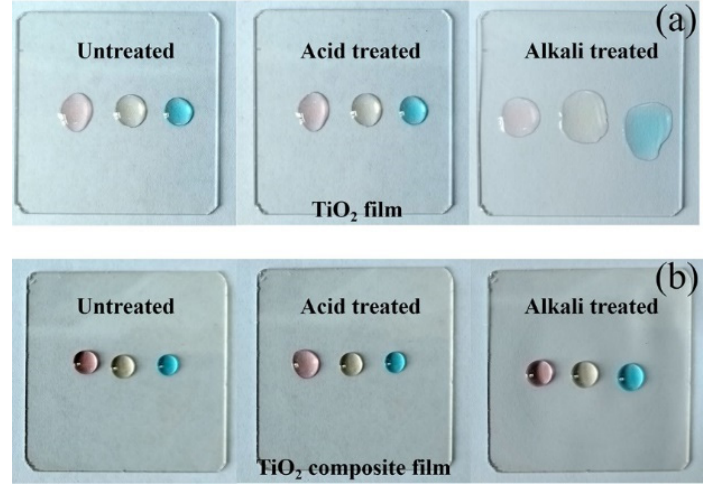
Figure 12. Photographs of ( a ) the calcined TiO 2 film and ( b ) the calcined keratinchar-TiO 2 composite film treated with 10% HCl and 10% NaOH at 30 °C for 24 h.